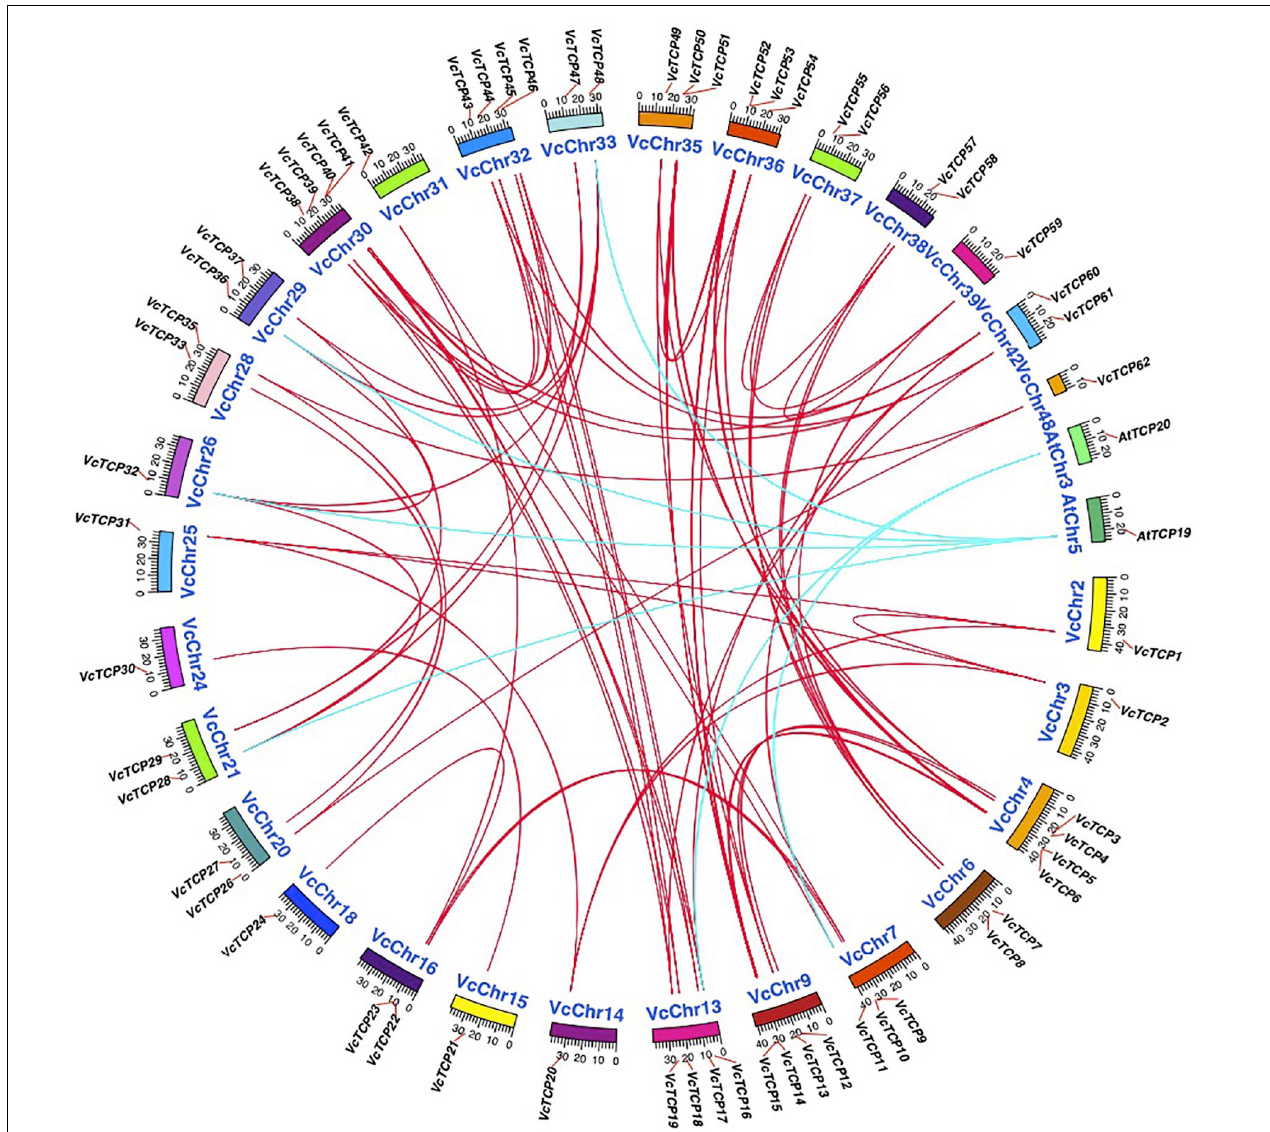
FIGURE 5 | Chromosome distribution and synteny analysis of blueberry and A. thaliana TCP genes. Chromosomes of V. corymbosum and A. thaliana are shown in different colors and circular form. The approximate distribution of VcTCPs and AtTCPs are marked with a short red line on the circle. Red and blue curves denote the details of syntenic regions between blueberry and A. thaliana TCP